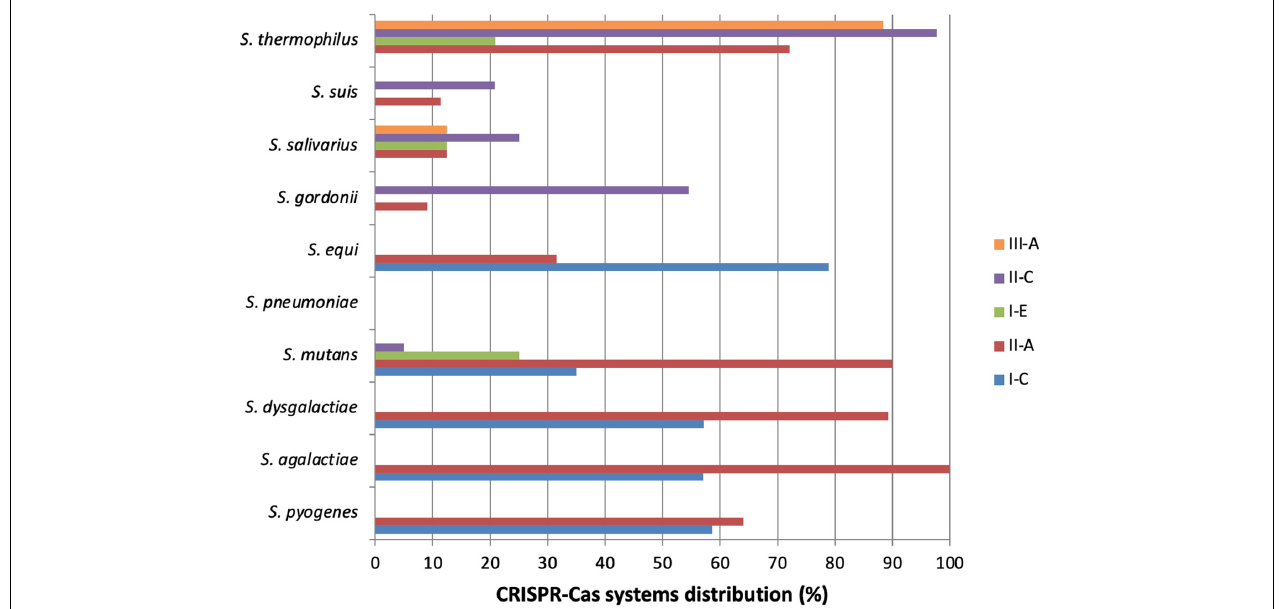
FIGURE 2 | Distribution of CRISPR-Cas systems in Streptococcus species. This graph represents the distribution of CRISPR-Cas systems in some Streptococcus species. It is based on the data available on “CRISPR finder” online, considering the tool limits. Particularly for S. thermophilus , it is important to notice that type II-C CRISPR-Cas systems found are actually type II-A. Only species of which at least 10 strains have been sequenced and analyzed are represented. S. thermophilus ( n = 43) , S. suis ( n = 53) , S. salivarius ( n = 16) , S. gordonii ( n = 11) , S. equi ( n = 19) , S. pneumoniae ( n = 141) , S. mutans ( n = 20) , S. dysgalactiae ( n = 28) , S. agalactiae ( n = 121) , S. pyogenes ( n =